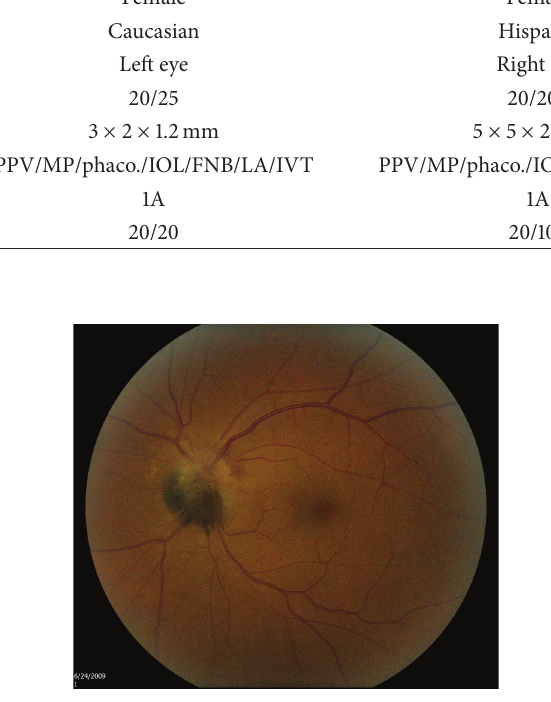
Figure 1: Case 1: fundus photograph of optic disk